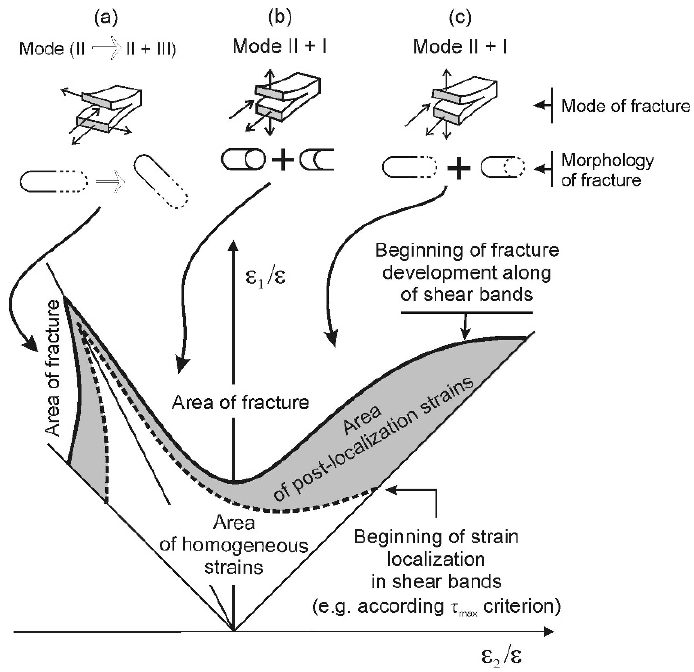
Figure 14. Effect of state of strain on mode and morphology of sheet metal fracture.